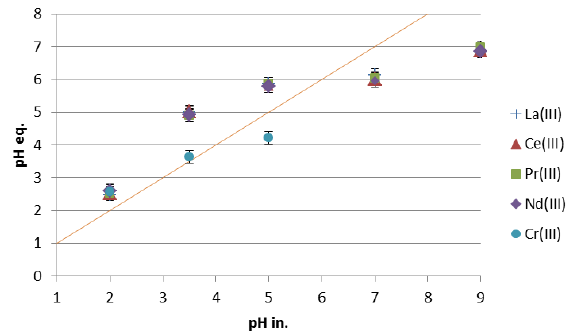
Figure 2. The e ff ect of initial pH on equilibrium pH Figure 2. The effect of initial pH on equilibrium pH values. Figure 2. The effect of initial pH on equilibrium pH values.